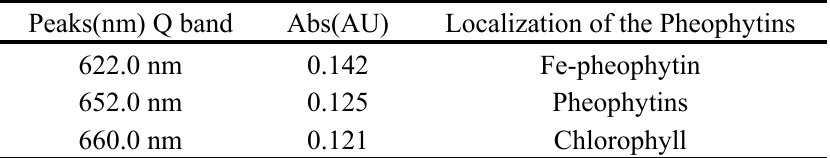
Table 2. Pheophytins in the visible zone Q band.